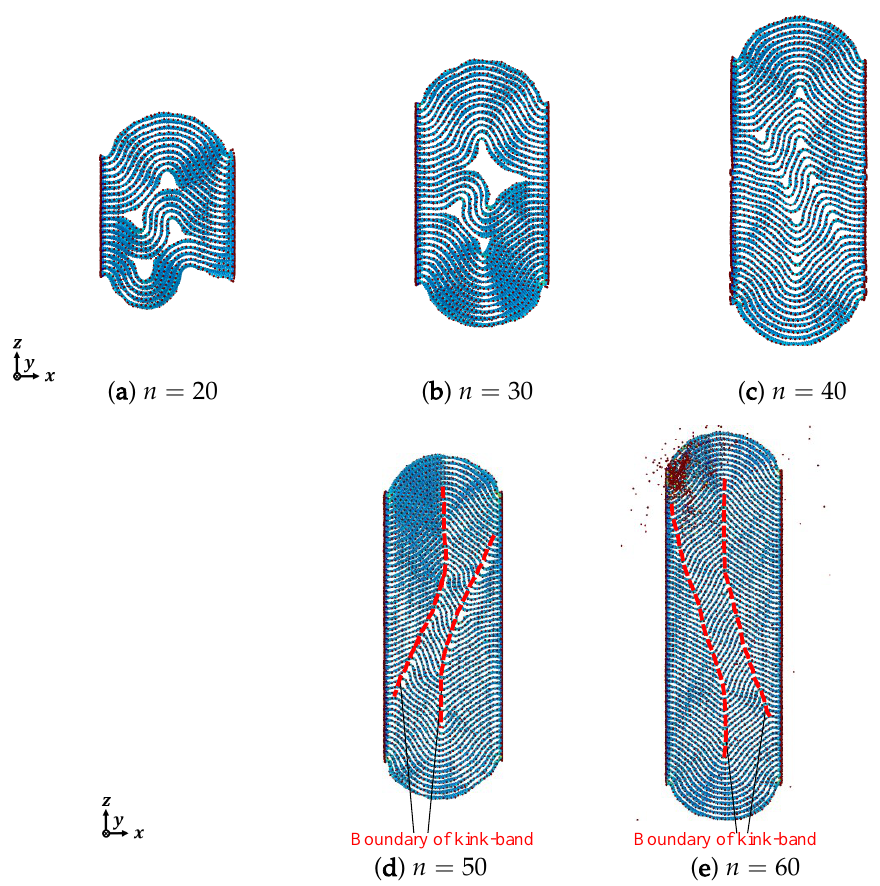
Figure 7. Deformation of zigzag graphite under compression( n = 40).